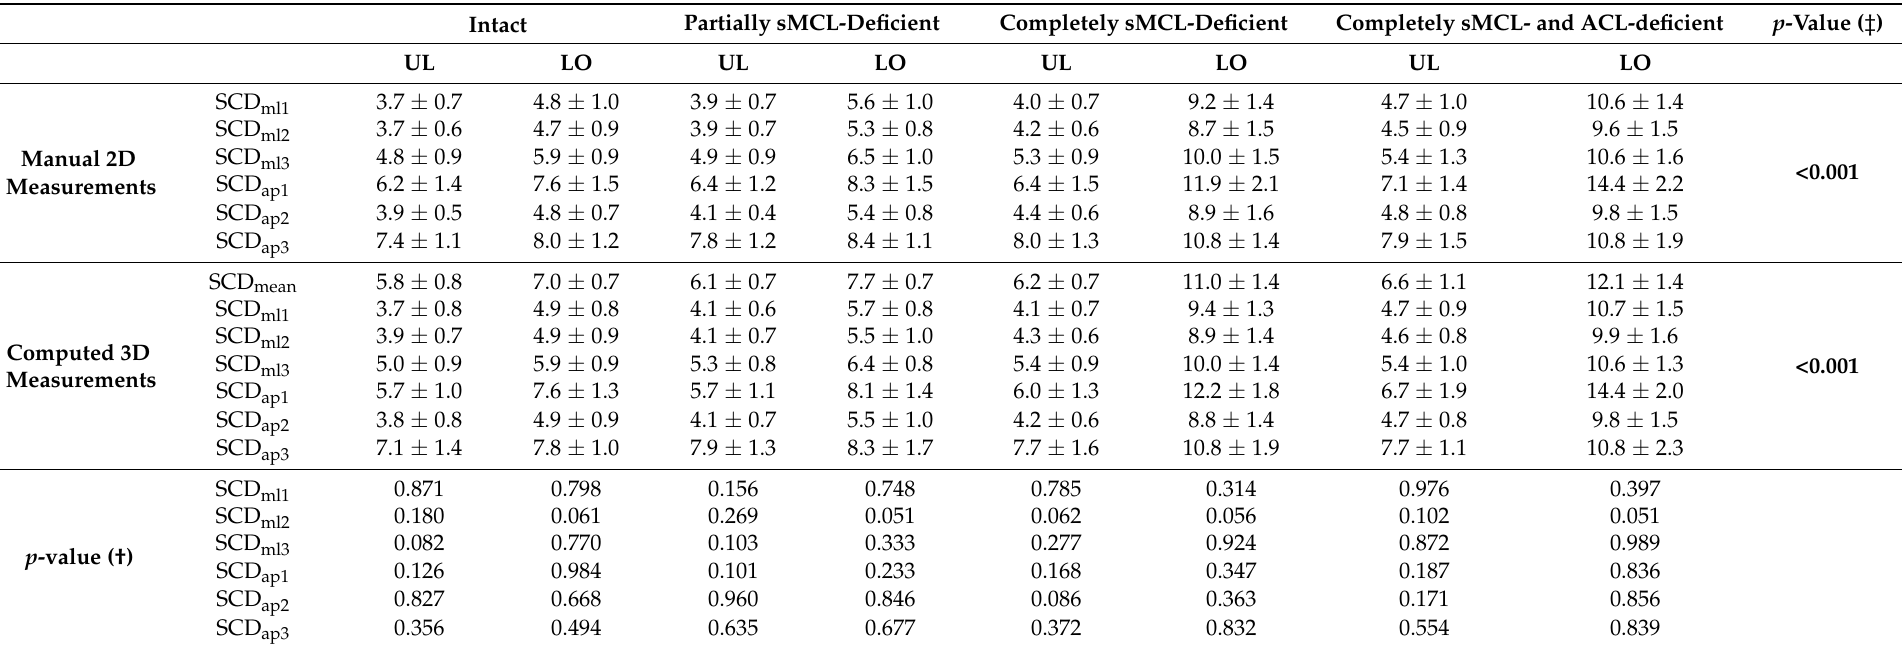
Table 2. Manual 2D and computed 3D measures of medial compartment opening as a function of valgus loading and graded knee joint ligament injury. Manual 2D measurements of subchondral cortical distances (SCDs) were performed at six pre-specified locations (SCD ap1 to SCD ap3 and SCD ml1 to SCD ml3 ) by two readers. Because of excellent inter-reader agreement, measurements were pooled. SCD mean indicates the averaged SCD values over the entire medial compartment. Mean ± standard deviation [mm]. Repeated measures two-way ANOVA was used to assess the SCD values of each location longitudinally and as a function of configuration (i.e., unloaded [UL], loaded [LO]) and condition (i.e., intact, partially, and completely sMCL-deficient, and completely sMCL- and ACL-deficient); respective p -values are indicated line-wise (‡). Paired Student’s t -test was used to comparatively evaluate SCD values of manual 2D measurements and computed 3D measurements; respective p -values are indicated column-wise (†). Significant differences are highlighted in bold-typed p -values and corresponding post-hoc results are detailed in Supplementary Table S1. Abbreviations as defined in Figure 6. Intact Partially sMCL-Deficient Completely sMCL-Deficient Completely sMCL- and ACL-deficient p -Value ( ‡ )